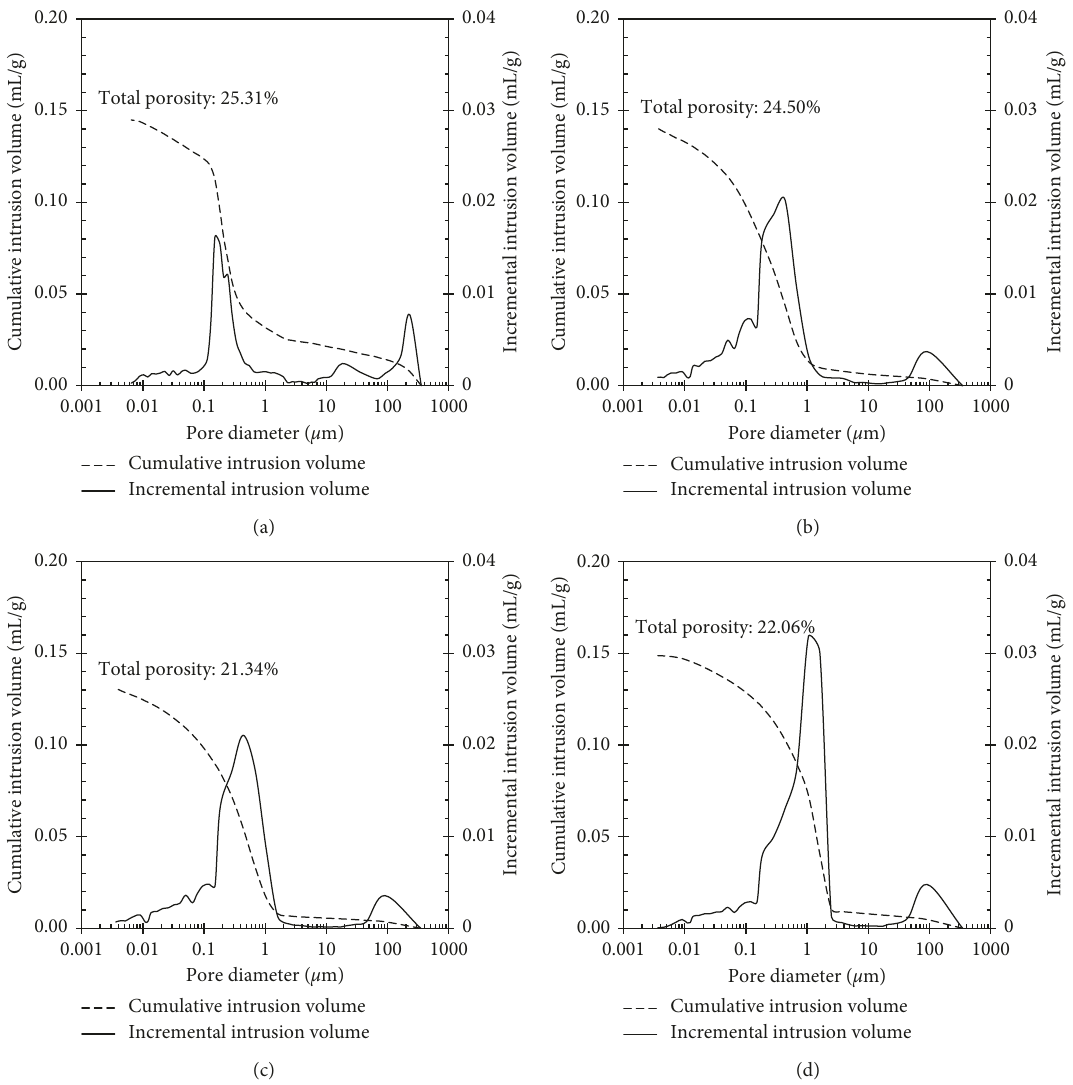
Figure 7: MIP results, rendered by incremental and cumulative intrusion volume with pore diameter, for mortar of CAC-GGBS mixtures: (a) CAC 100; (b) CAC 80; (c) CAC 60; (d) CAC